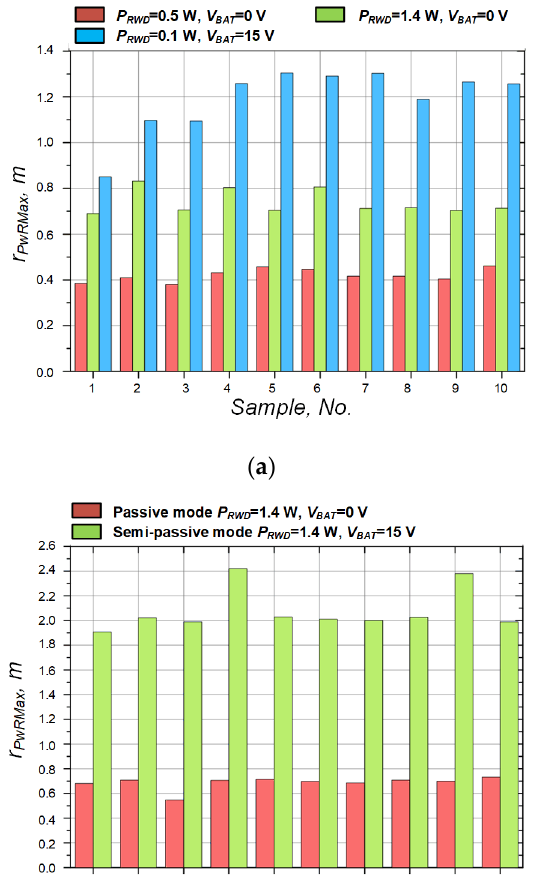
( b ) Figure 12. Outside tests: ( a ) measurement application; ( b ) test sample of RFID sensor with external sensors. In order to implement the scenarios discussed, it is important to determine whether it is possible to obtain enough energy that is needed for a stable operation of the RFID sensor in the transition periods of the daily cycle: night/day and day/night. The algorithm for acquiring and, if necessary, processing of measurement data starts after crossing the selected threshold voltage V ON . The daily cycle starts at this time and its length may vary from e.g., about 8 h to over 16 h (for the latitude of the experiment site). The end of the measurement procedure can be caused both by the end of the daily cycle (voltage drop below the V min value) and the implemented scheme of the parameter sampling. From this